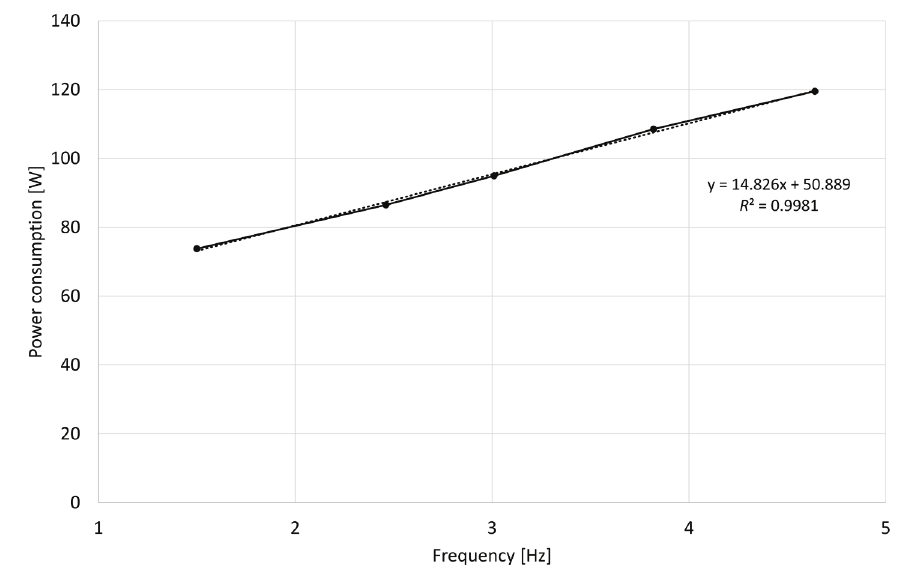
Fig. 2 – Influence of different densities on the energy input in the OFB shown as relative power increase (3 mm baffle, 6 mm amplitude)